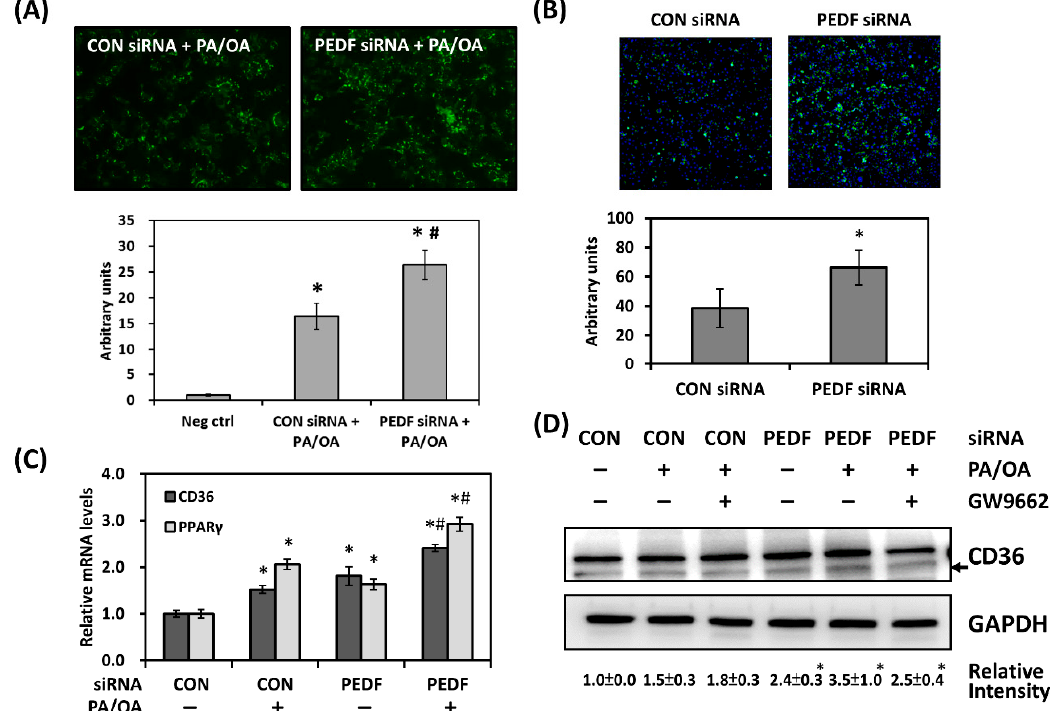
Figure 2. Knocking down PEDF increases lipid droplet accumulation and fatty acid uptake. ( A ) Magnification: 100 × . Hep3B cells were transfected with control or PEDF siRNA, followed by incubation with vehicle or fatty acid mixture (palmitic acid (PA) / oleic acid (OA)) for 24 h. Lipid droplet accumulation was assayed by BODIPY 493 / 503 staining. ( B ) Magnification: 100 × . Control and PEDF siRNA-transfected Hep3B cells were incubated with BODIPY FL C16 to assay fatty acid uptake. Fluorescence was then normalized to DAPI stained cell number. ( C ) Control and PEDF siRNA-transfected Hep3B cells were treated with PA / OA. Gene expression was determined using quantitative RT-PCR for CD36 and PPAR γ and ( D ) immunoblotting for CD36. CD36 band intensity was quantified, normalized to that of GAPDH, and presented as mean ± standard deviation. GW9662: PPAR γ inhibitor (5 µ M). *, Statistically significant compared with the untreated (or control transfected, untreated) group at p < 0.05; #, statistically significant compared with the PEDF siRNA, untreated group at p < 0.05. siRNA: small interfering RNA. PPAR γ : peroxisome proliferator-activated receptor γ .